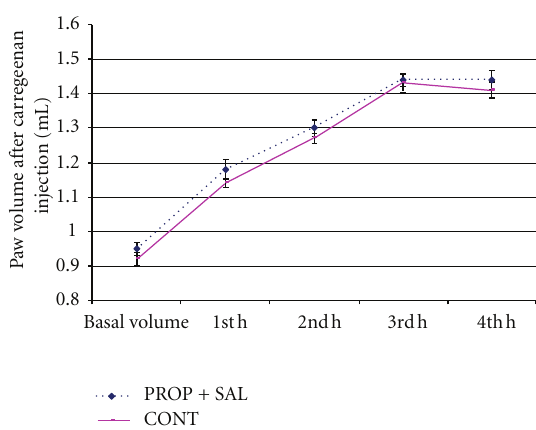
Figure 1: E ff ects of combination of salbutamol (2mg/kg) and propranolol (40mg/kg) (PROP + SAL) on carrageenan-induced inflammatory paw volume in rats. CONT: